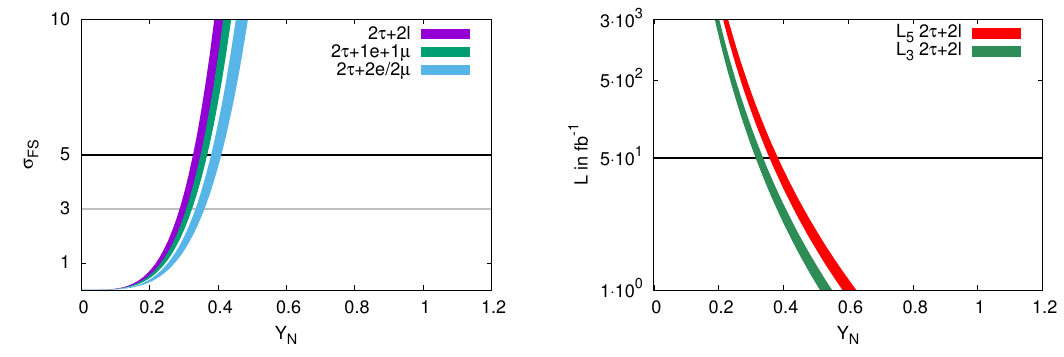
Figure 3 . (Left panel) We present the signal signi(cid:12)cance verses Y N for the chosen (cid:12)nal states at an integrated luminosity of 100 fb (cid:0) 1 . (Right panel) The required luminosity for 5 (cid:27) signal signi(cid:12)cance ( L 5 ) verses Y N are shown for 2 (cid:28) + 2 ‘ (cid:12)nal state with center of mass energy of 14 TeV at the